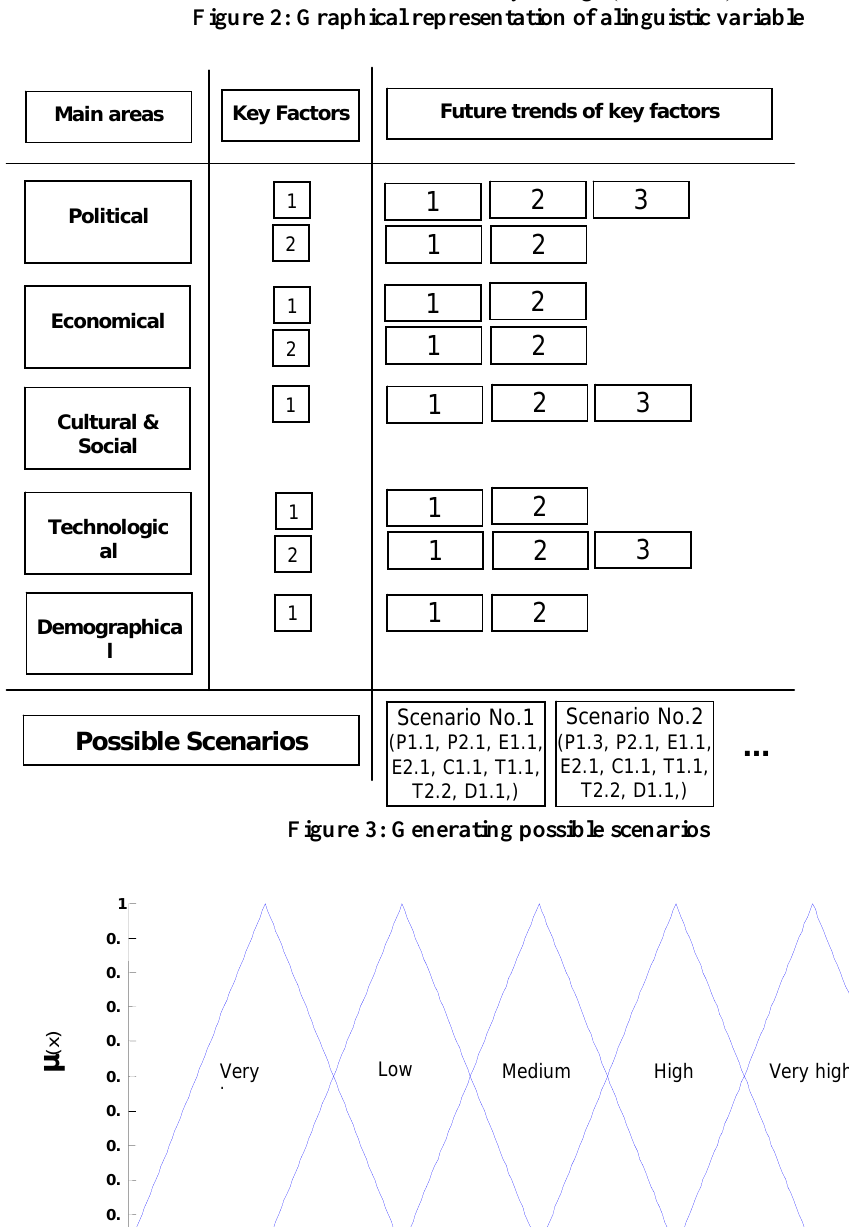
Figure 4: Linguistic variables for